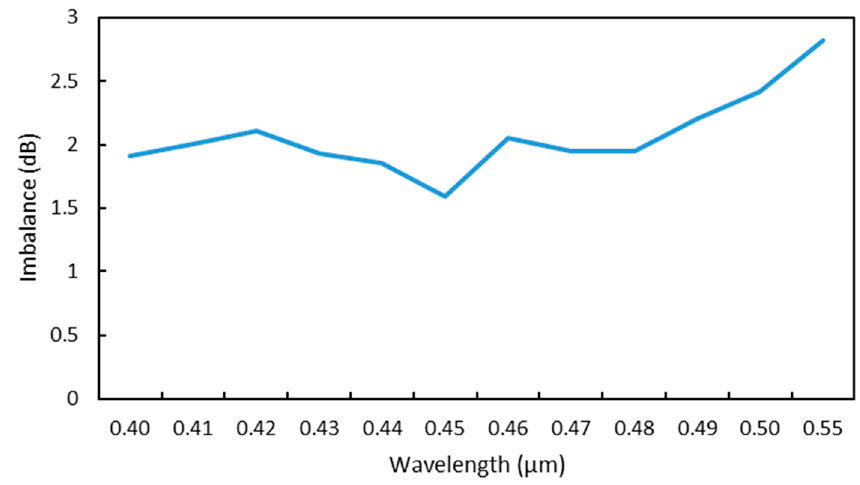
Figure 11. The power imbalance of the transverse electric (TE) mode in the proposed optical power divider.